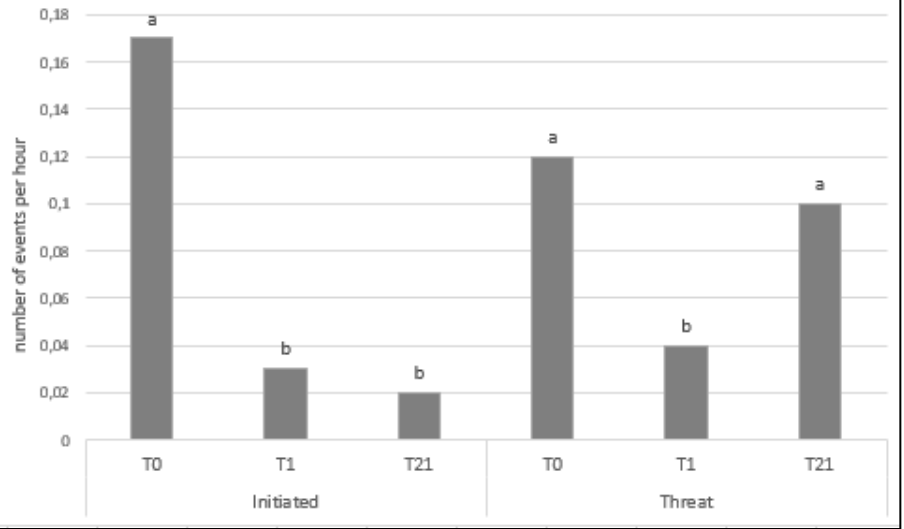
Figure 3. Average number of initiated aggressive behaviors and threats per hour according to the time after mixing: the day of mixing (T0), the day after mixing (T1), and three weeks later (T21). a, b: Different letters indicate significant differences ( p < 0.05) over time.